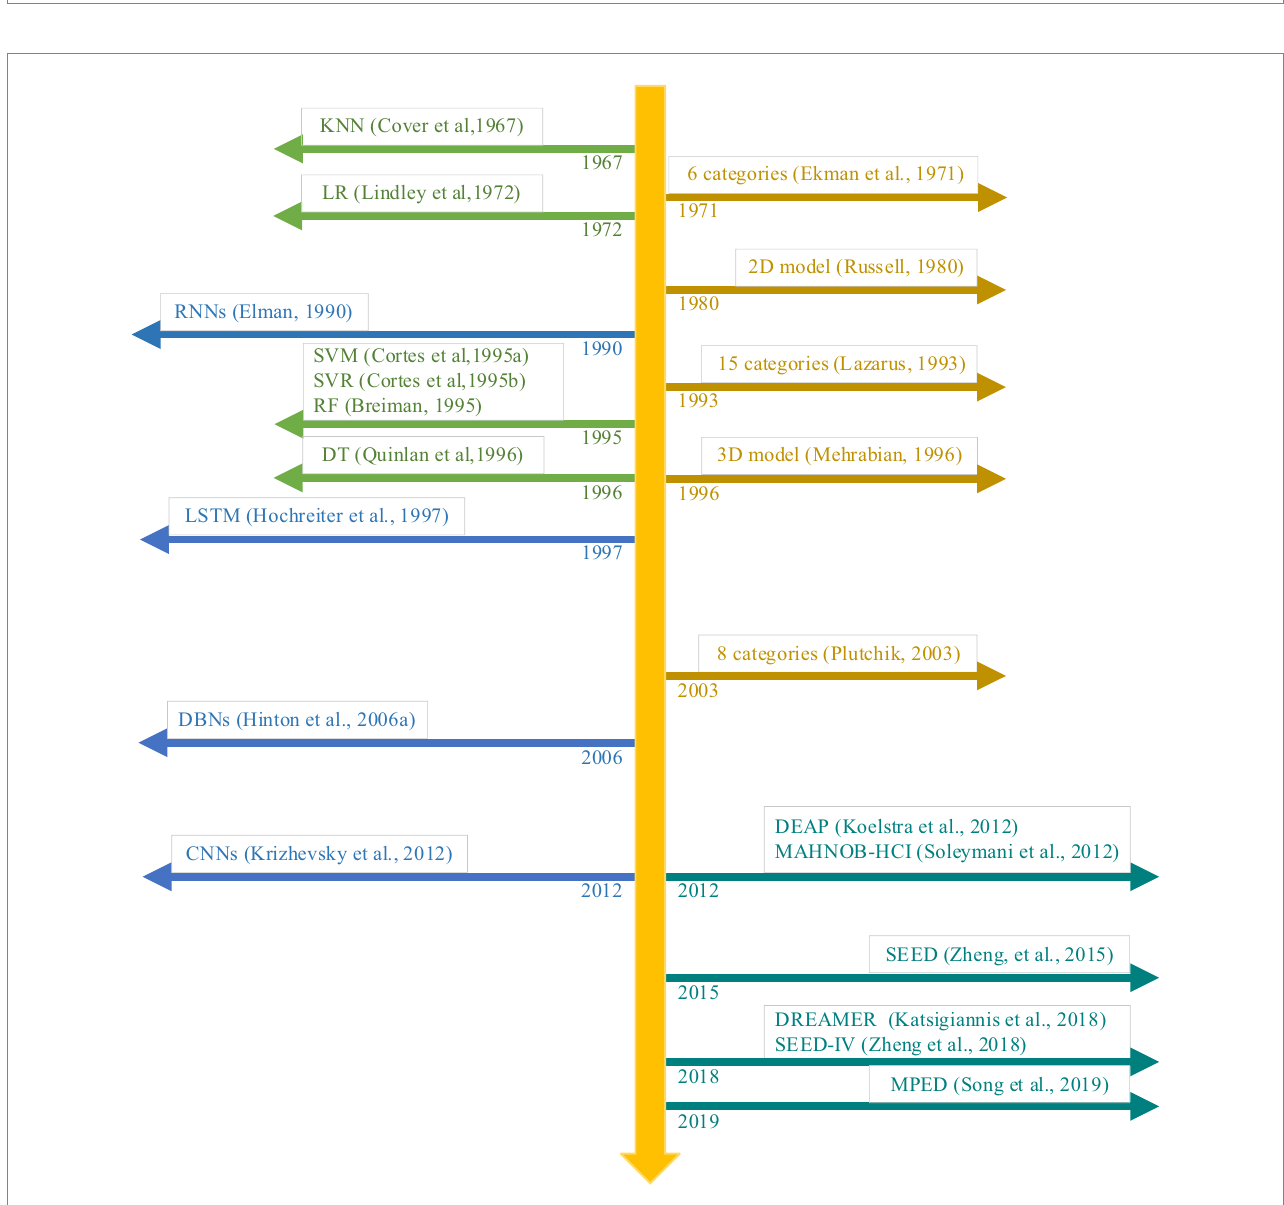
FIGURE 2 The evolution of EEG emotion recognition with deep learning algorithms, emotion categories and